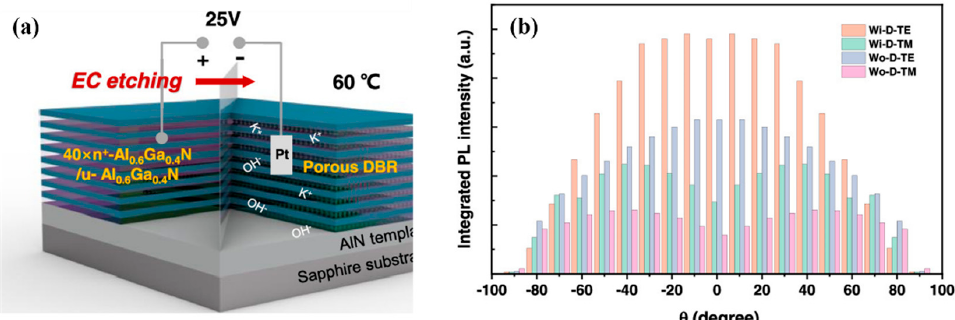
Figure 8. ( a ) Schematic diagram for the structure and fabrication of AlGaN-based NP-DBRs. ( b ) Full spatial TE/TM mode light intensity distributions in the Wi-D and Wo-D regions. Reproduced from Ref. [107] with permission from the American Chemical Society.